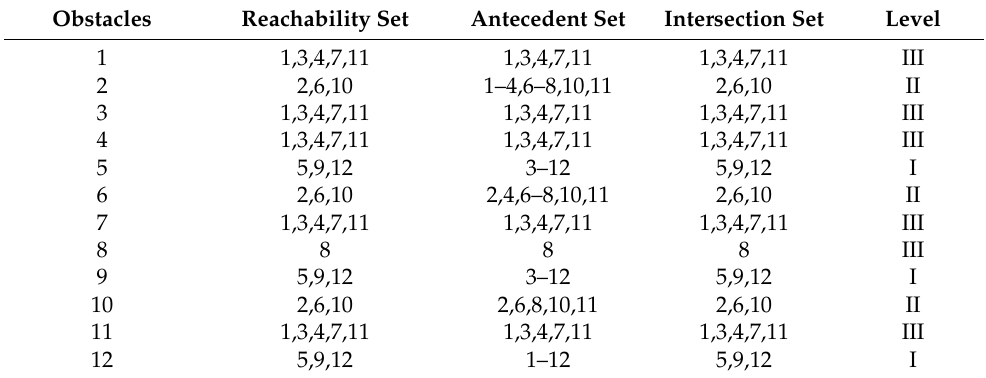
Table 10. Level partition for